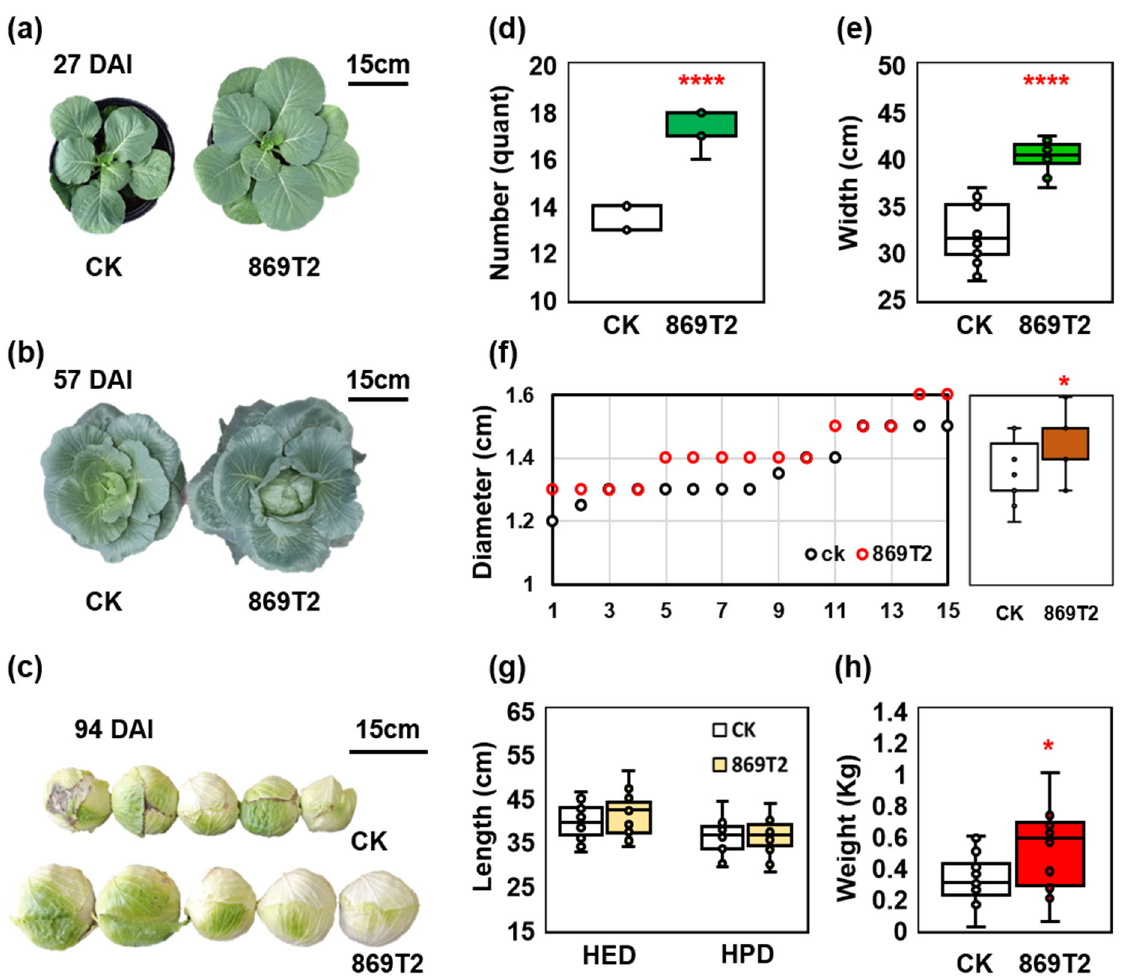
Figure 1. B. seminalis 869T2 improves the growth of cabbage. The phenotype of seedlings and ( b ) 57 DAI; ( c ) phenotype of the harvested leafy heads at 94 DAI. The ( d ) leaf quant and ( e ) rosette at ( a ) 27 DAI and ( b ) 57 DAI; ( c ) phenotype of the harvested leafy heads at 94 DAI. The width of seedlings at 27 DAI. The ( f ) stem diameter, ( g ) head circumference and ( h ) fresh weight of ( d ) leaf quant and ( e ) rose tt e width of seedlings at 27 DAI. The ( f ) stem diameter, ( g ) head harvested leafy heads at 94 DAI. DAI, days after inoculation. HED, head equatorial diameter. HPD, circumference and ( h ) fresh weight of harvested leafy heads at 94 DAI. DAI, days after head polar diameter. n = 15. * p < 0.05, **** p < 0.001; otherwise, no inoculation. HED, head equatorial diameter. HPD, head polar diameter. n = 15. * p < 0.05, **** p < 0.001; otherwise, no signi fi cant.